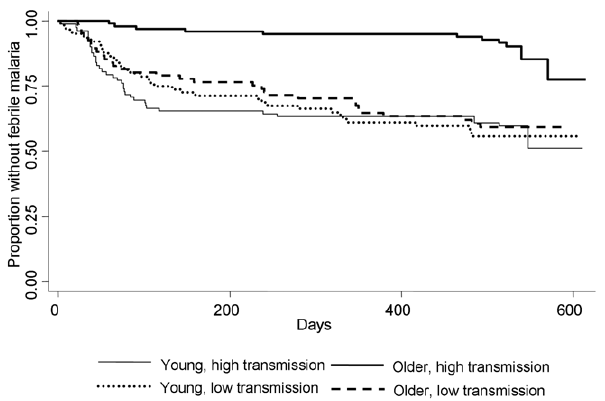
Figure 2. Survival plot of time to first episode of febrile malaria ( . 2,500 parasites per m l). Children are divided by age (in two categories) and by residence (in two transmission zones). P , 0.0001 by logrank.